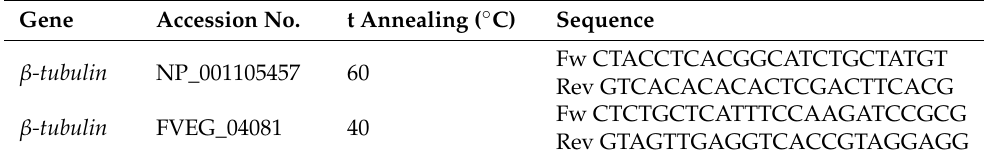
Table 2. Primers used in this